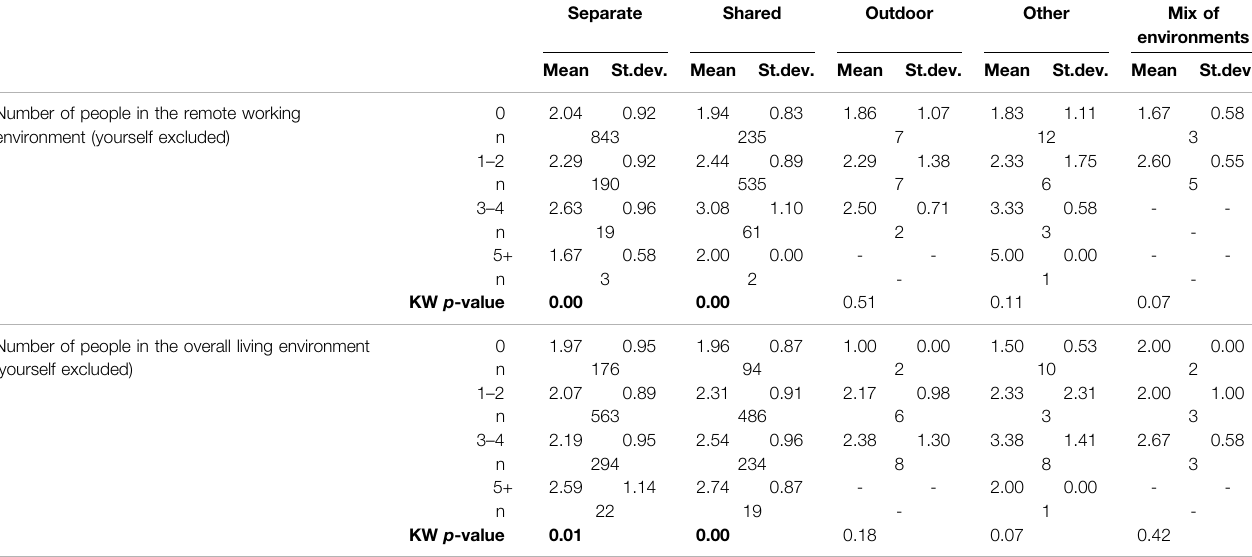
TABLE 9 | Mean and standard deviation (St.dev.) values of the answers on noise annoyance (Q1) related to the number of people in the remote working environment and in the overall living environment, considering the overall sample ( n (cid:1) 1934). Two-tailed p -values of signi fi cance of the differences according to the Kruskal Wallis (KW) Test are reported. Statistically signi fi cant differences with p -values < 0.05 are reported in bold. Separate Shared Outdoor Other Mix of